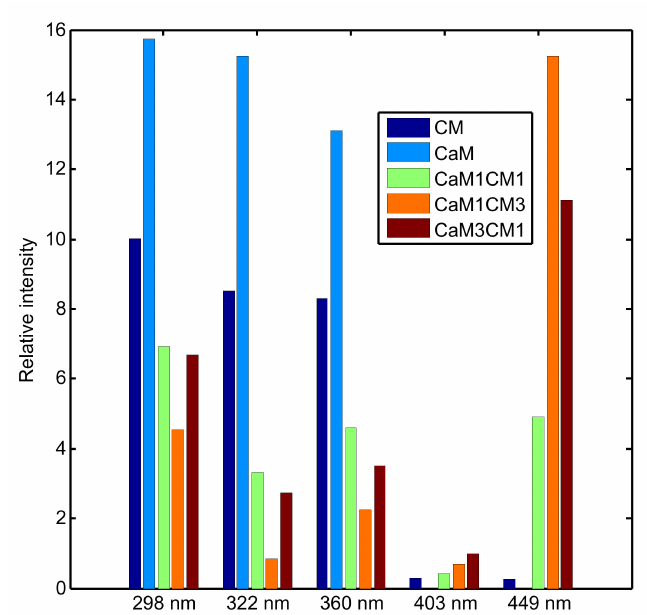
Figure 3. Relative auto-peak intensity of CM (cow’s milk), CaM (camel’s milk) and their